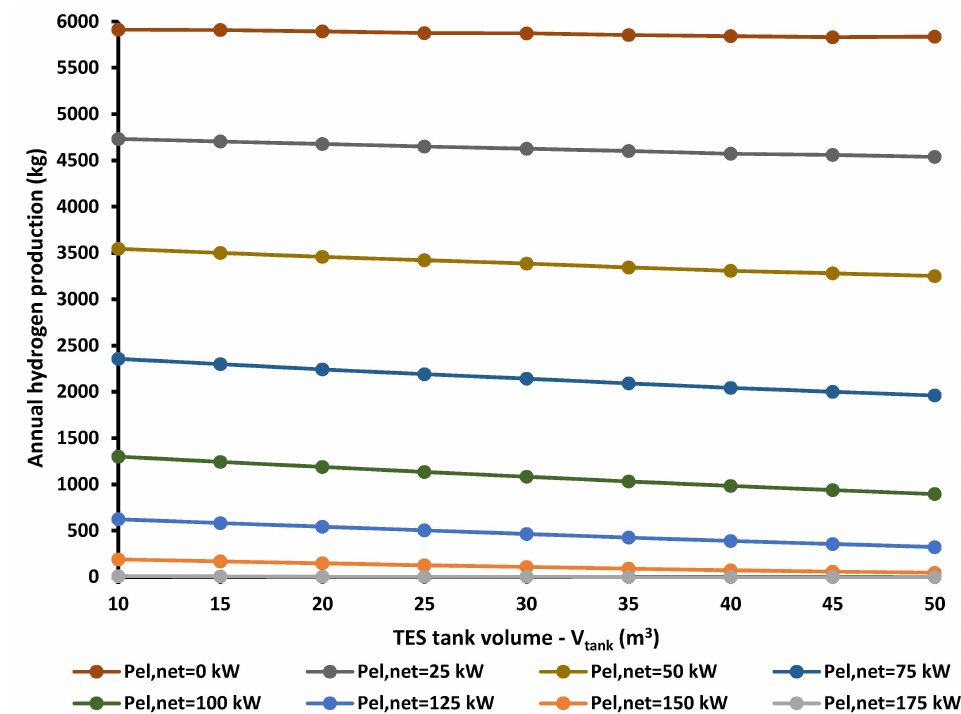
Figure 9. Annual hydrogen production for different values of net electricity load and TES tank